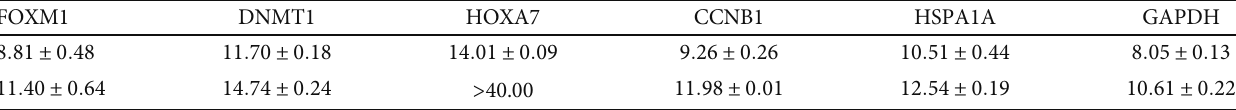
Table 1: Mean Ct values of kit and UC samples.